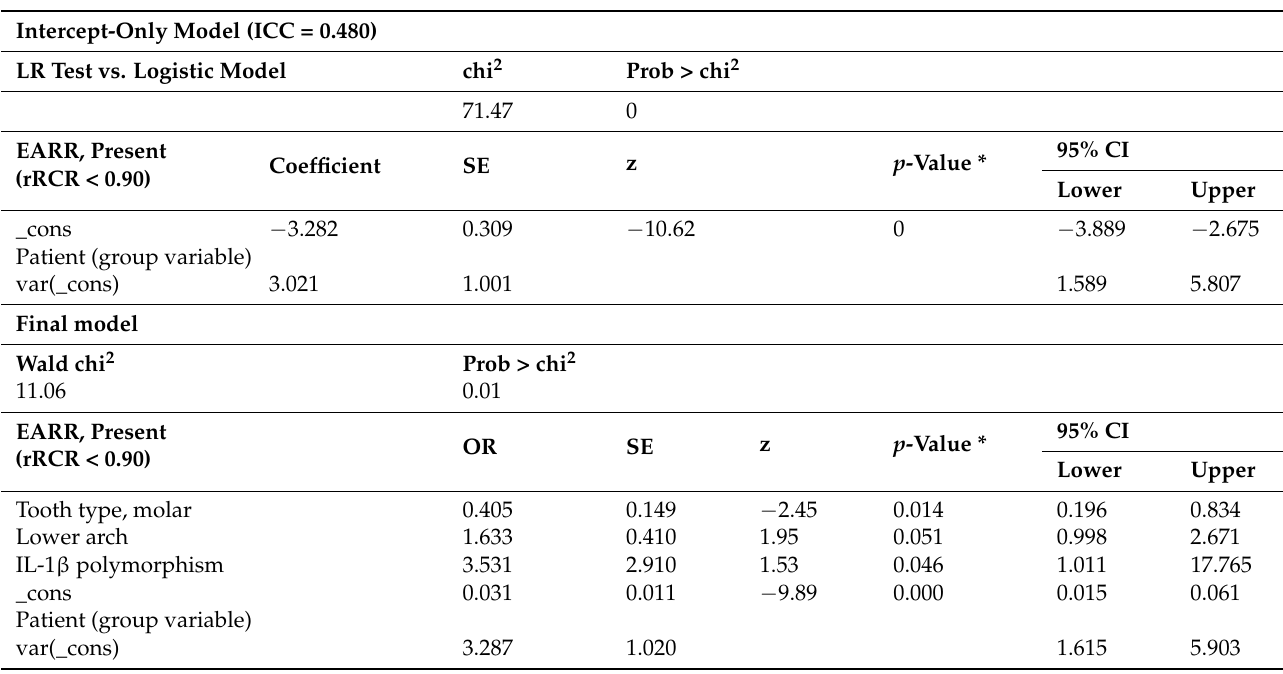
Table 3. Intercept-only model to demonstrate the evidence of significant clustering of teeth (Level 1) according to patient- level (Level 2). Moreover, results of the multi-level binary logistic model with EARR as the dependent variable are presented together with the following predictors: tooth type (Level 1), lower arch (Level 1), and IL-1 β polymorphism (Level 2). Intercept-Only Model (ICC =